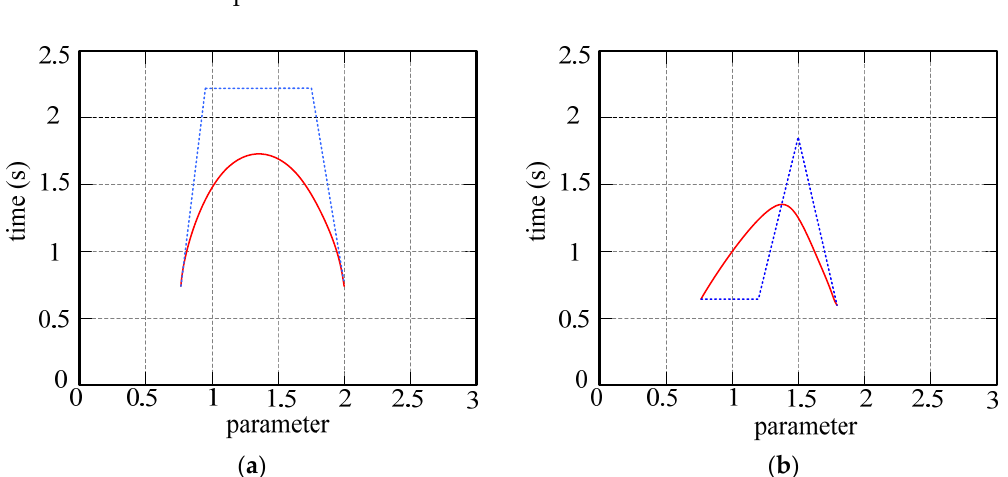
Figure 4. Two Bezier curves. ( a ) First-order curve, ( b ) Quadratic curve.